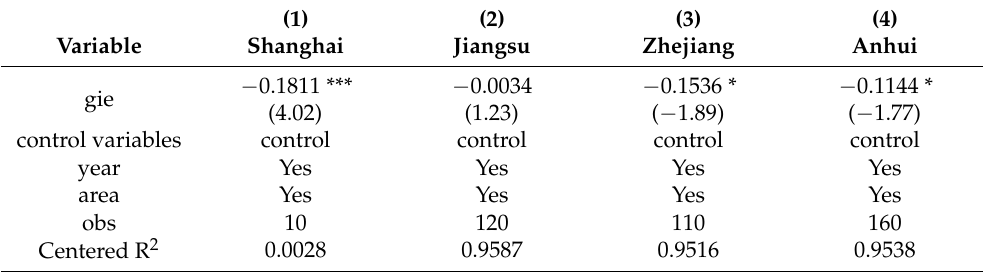
Table 4. Regional heterogeneity analysis.